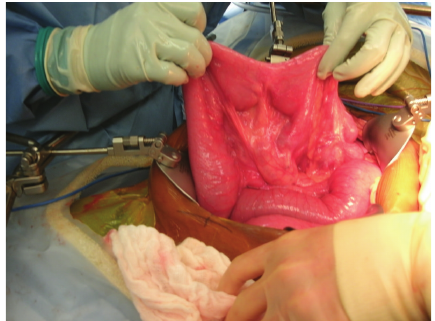
Figure 4: Area of narrowed bowel near the terminal